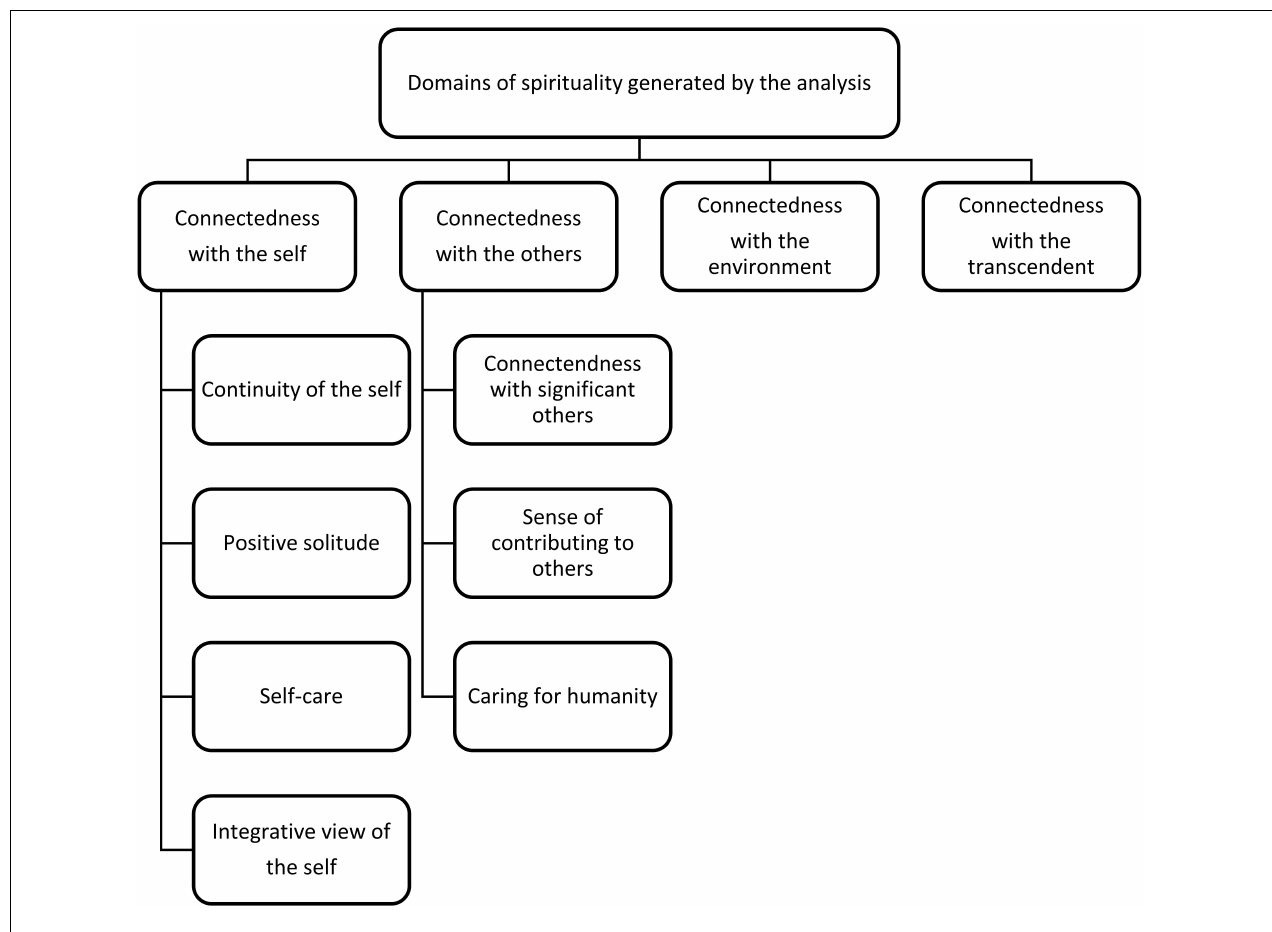
FIGURE 1 | The thematic map.